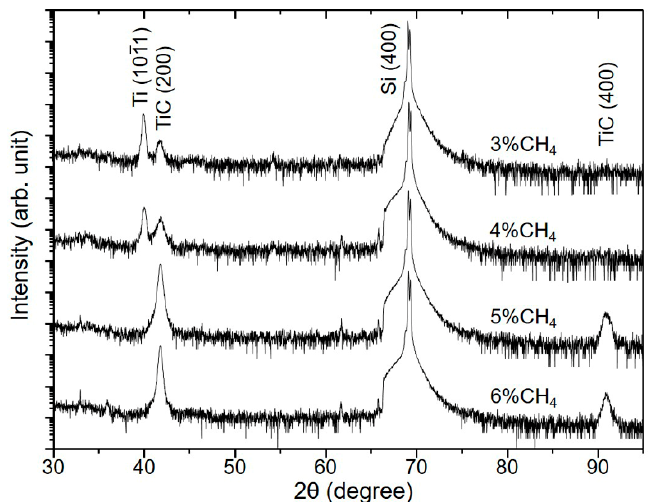
Figure 1. X-ray diffraction (XRD) 2 θ - ω patterns of TiC films deposited on Si (100) substrates for different CH 4 flow ratios.